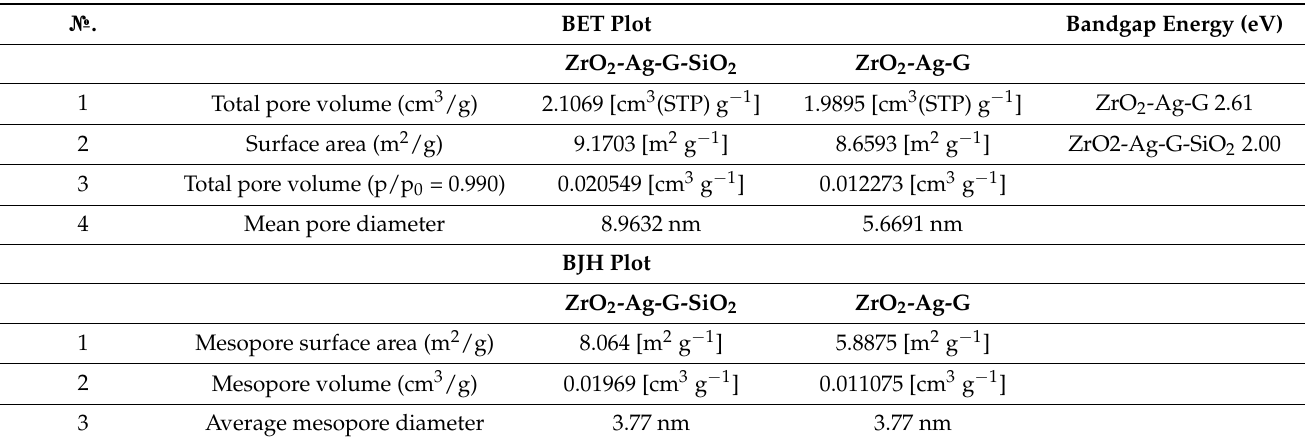
Table 1. Surface properties obtained from nitrogen adsorption-desorption isotherms of ZAGS. №